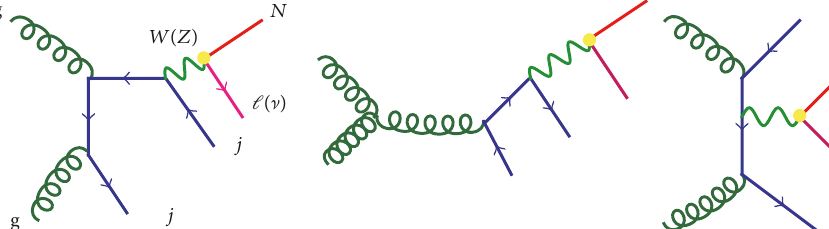
Figure 7: 2-jet process to produce 𝑁 with ℓ( ] ) in association with a jet from the CC(NC) interaction from gg initial